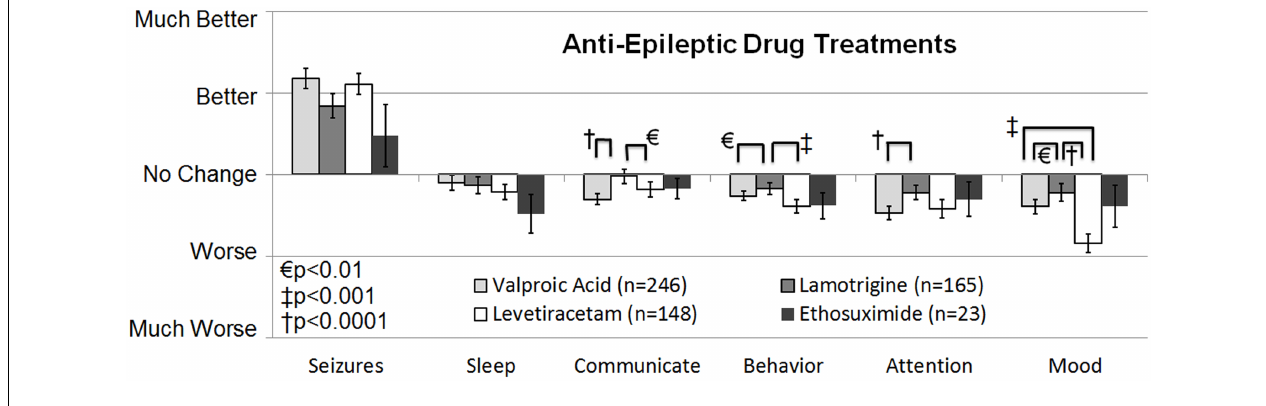
Table3 fortheseAEDswereabstractedfromthissystematicreview. abstracted from data on partial onset seizures in children. For levetiracetam, ethosuximide, and gabapentin there was no data